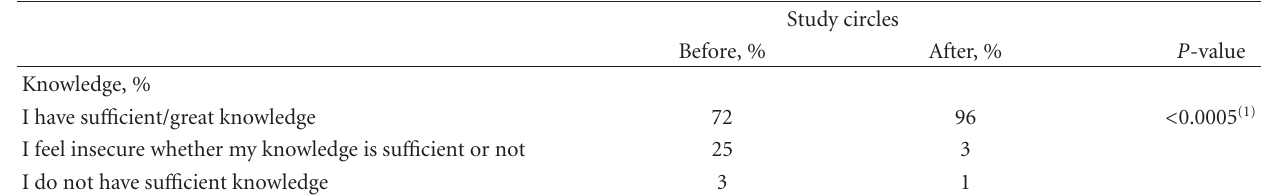
Table 3: Study circle participants’ ( n = 592) retrospective self-evaluation of their knowledge